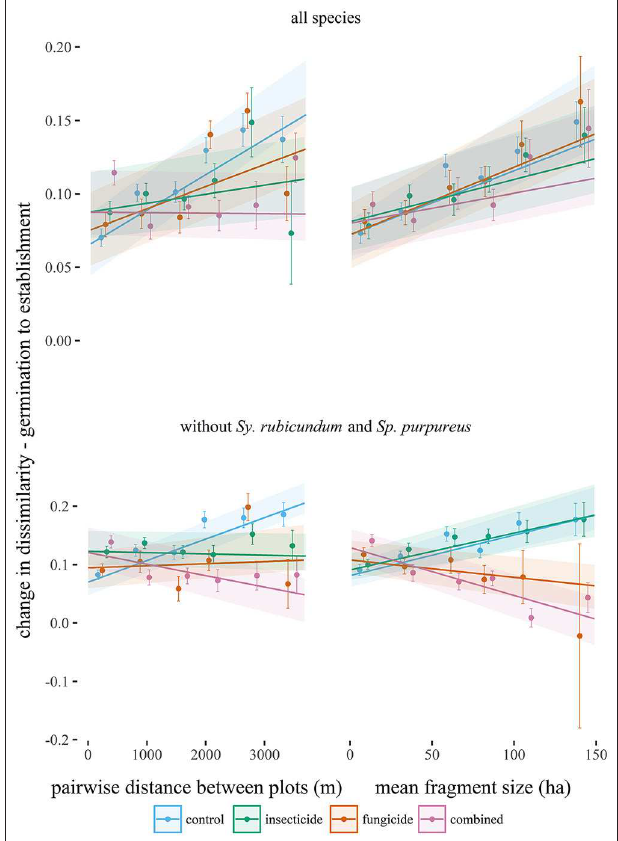
FIGURE 3 | Changes in the pairwise Bray-Curtis dissimilarities ( β -diversity) between seedling assemblages (from germination to establishment) plotted against the distance between plots, and against mean fragment size (from each pair of 1 m 2 plots), in each experimental treatment. Points (standardized by the estimated random effects) equal mean changes in dissimilarity in each of seven binned distance or fragment size classes and are plotted with standard errors. Lines are predicted from linear mixed effects models ( Table 2 ) and are plotted with standard